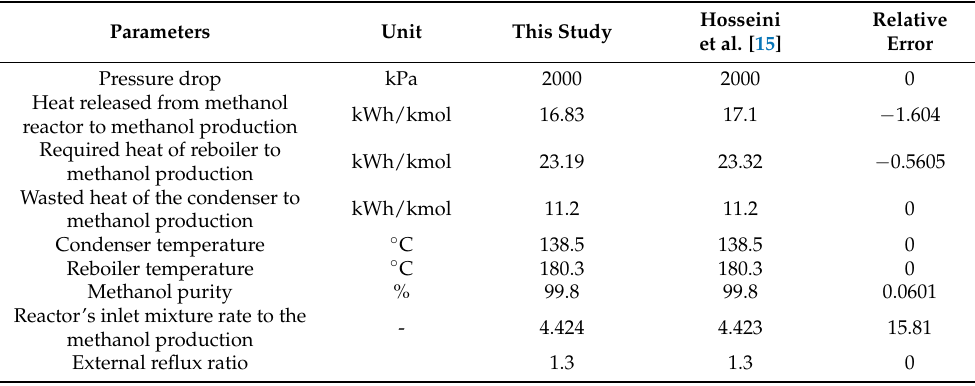
Table A3. Validation of the main parameters of the liquid methanol production cycle.